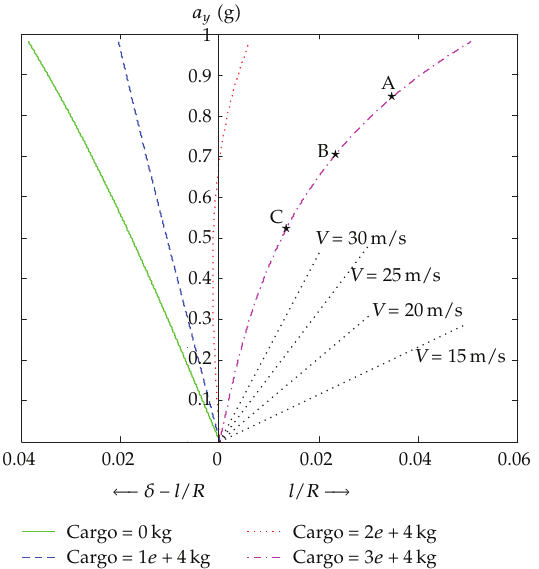
Figure 9: V -handling diagram for tractor semitrailer with one rear